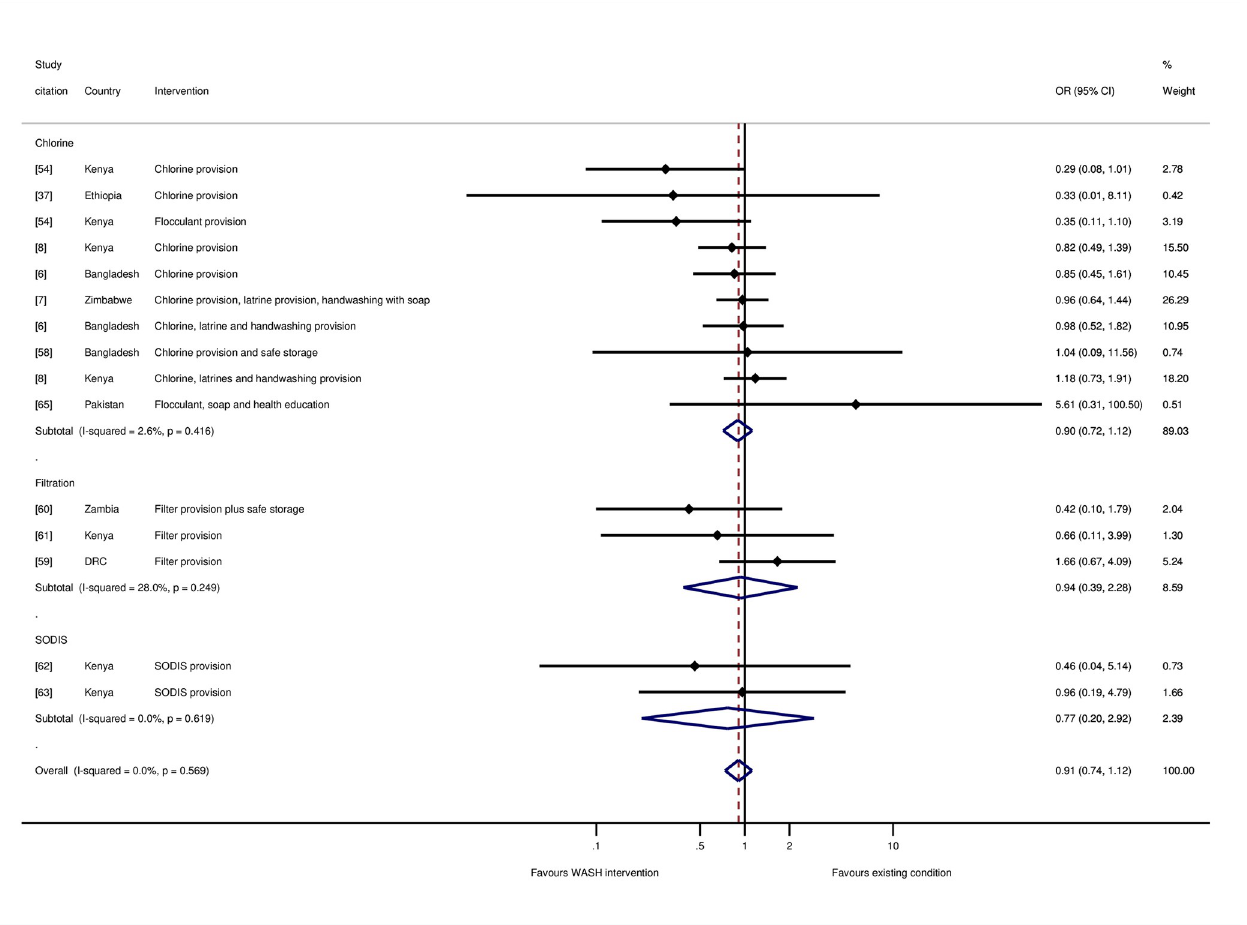
Fig 8. Effects on all-cause mortality in childhood of drinking water treatment and